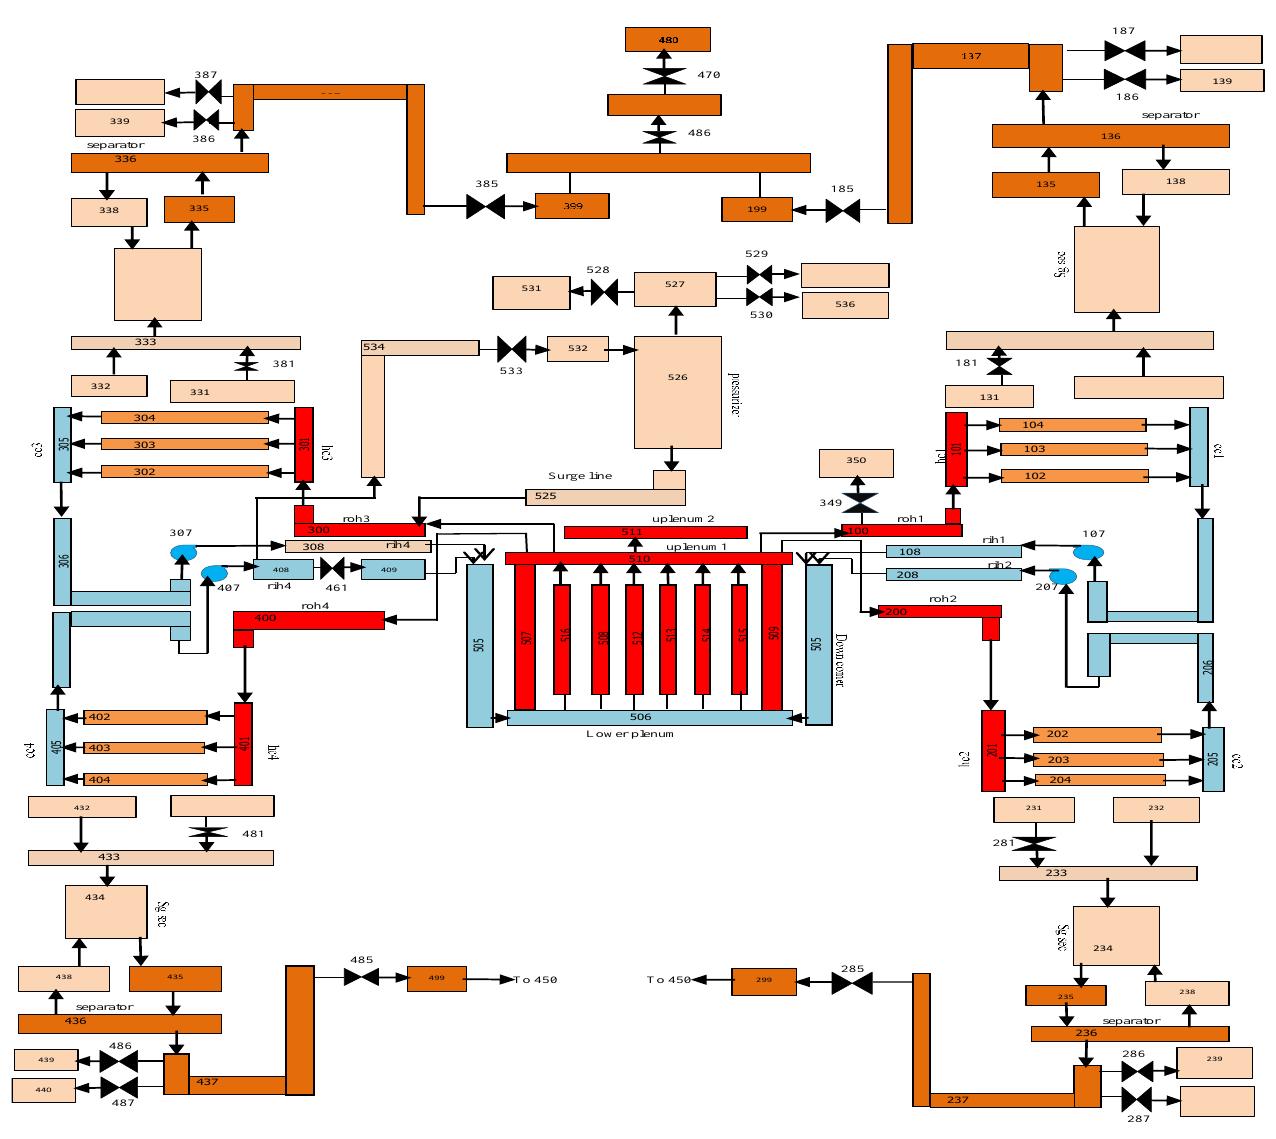
Figure 1. VVER-1000 nodalization.